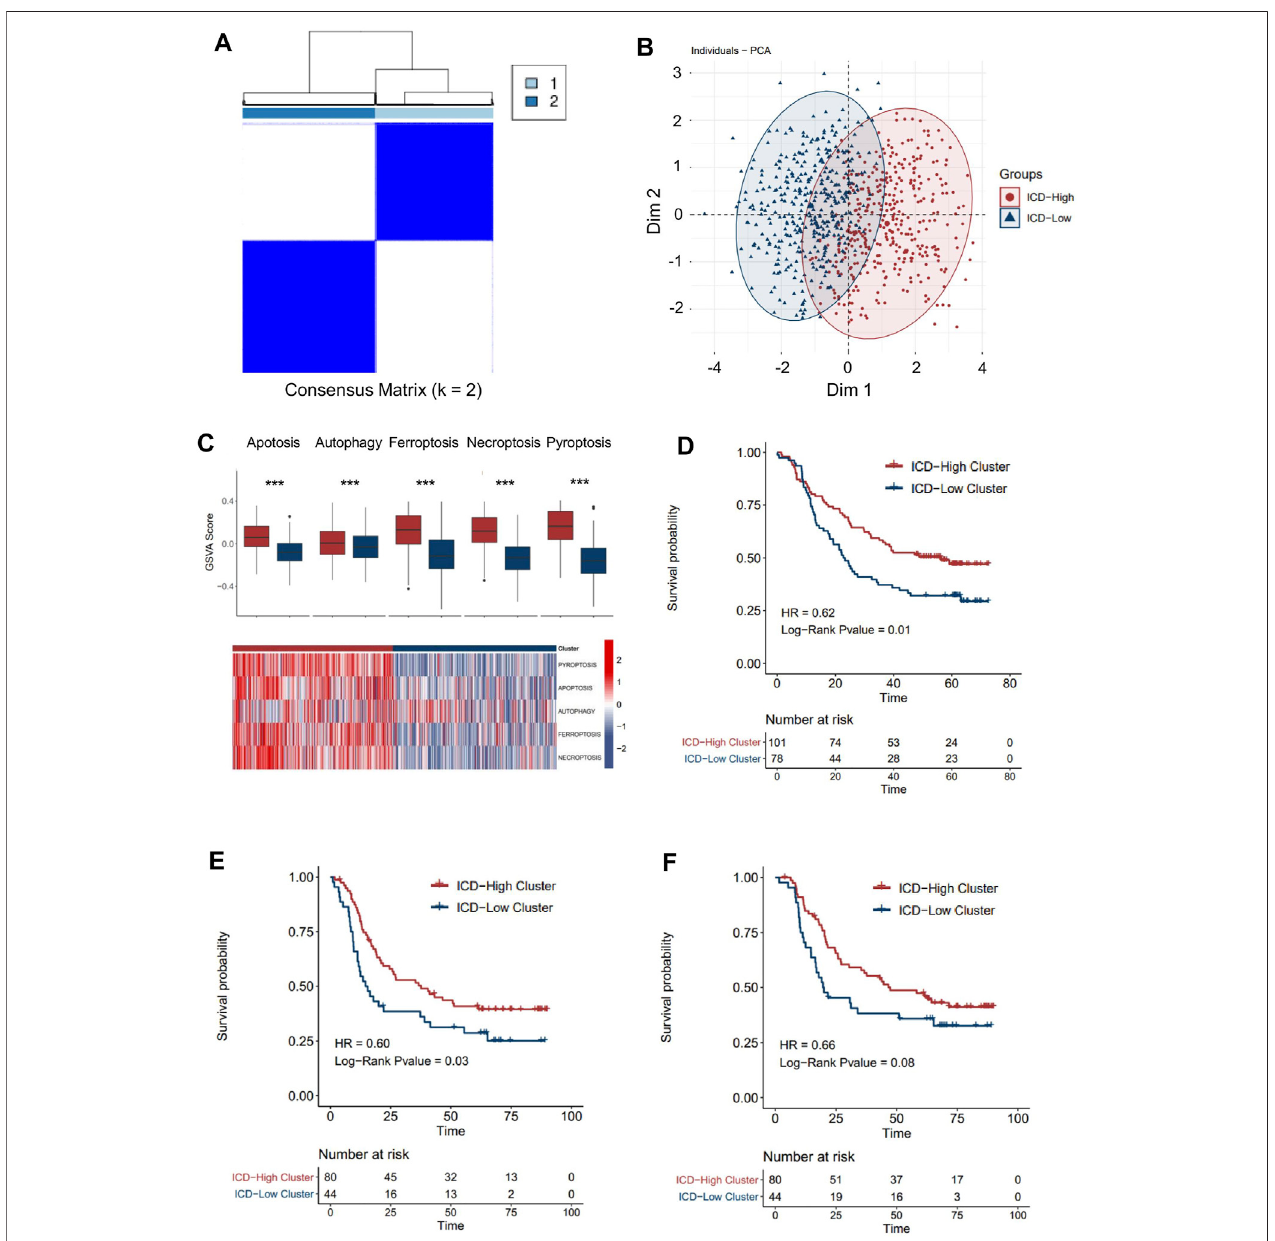
FIGURE 3 | Patterns of the immune cell death pathway and prognosis characteristics of each pattern. (A) Unsupervised clustering of three immune cell death pathways ’ GSVA scores in the transcriptomics level. (B) PCA analysis for two ICD clusters in the transcriptomics level. (C) Cell death pathway patterns of two ICD clusters in the transcriptomics level. Top: the bar plot shows the cell death pathway GSVA score of two ICD clusters. Bottom: the heatmap reveals the GSVA score pattern of two ICD clusters (D – F) . Kaplan – Meier analysis of overall survival (OS) or progression-free survival (PFS) comparing the ESCC patients with two ICD clusters. (D) Kaplan – MeieranalysisofOSinthetranscriptomicslevel. (E) Kaplan – MeieranalysisofPFSinthetranscriptomicslevel. (F) Kaplan – MeieranalysisofOSinthe proteomics level (red for the ICD-high cluster; blue for the ICD-low cluster).